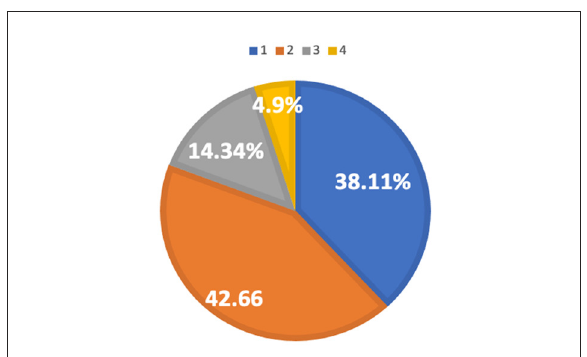
FIGURE7 Profile membership of L1 Mandarin speakers rated 50.